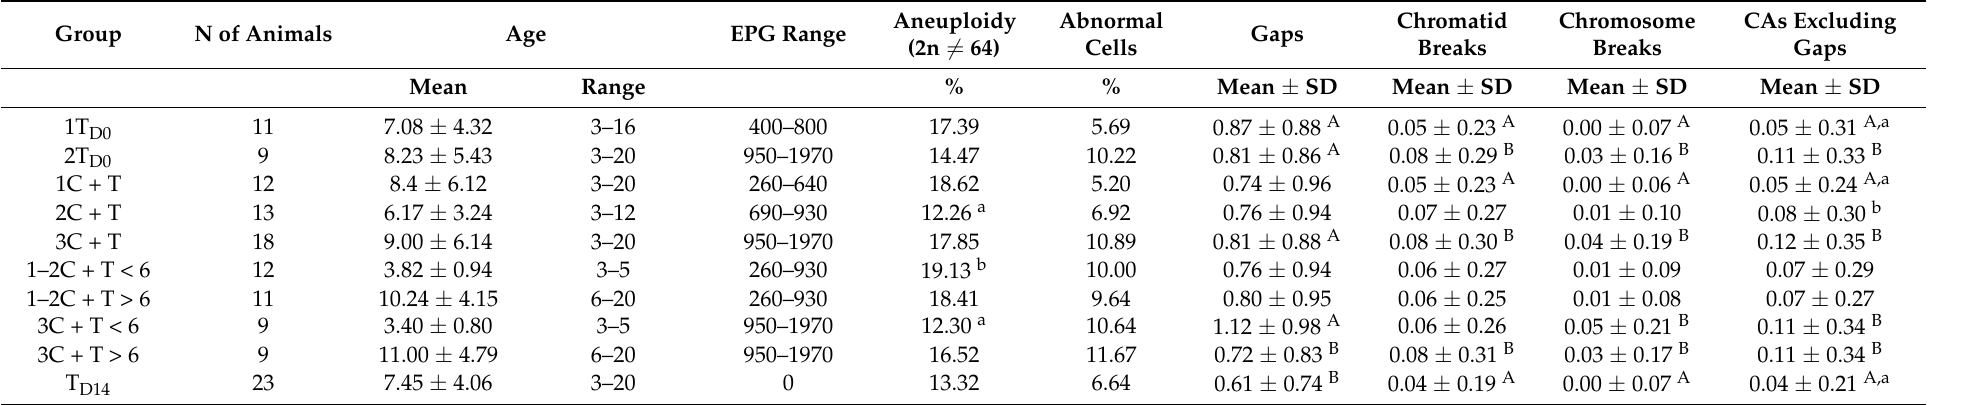
Table 2. Percentages of aneuploidy and abnormal cells and mean values and standard deviations of chromosome abnormalities in ponies grouped according to EPG and age at D0 and compared with the T D14